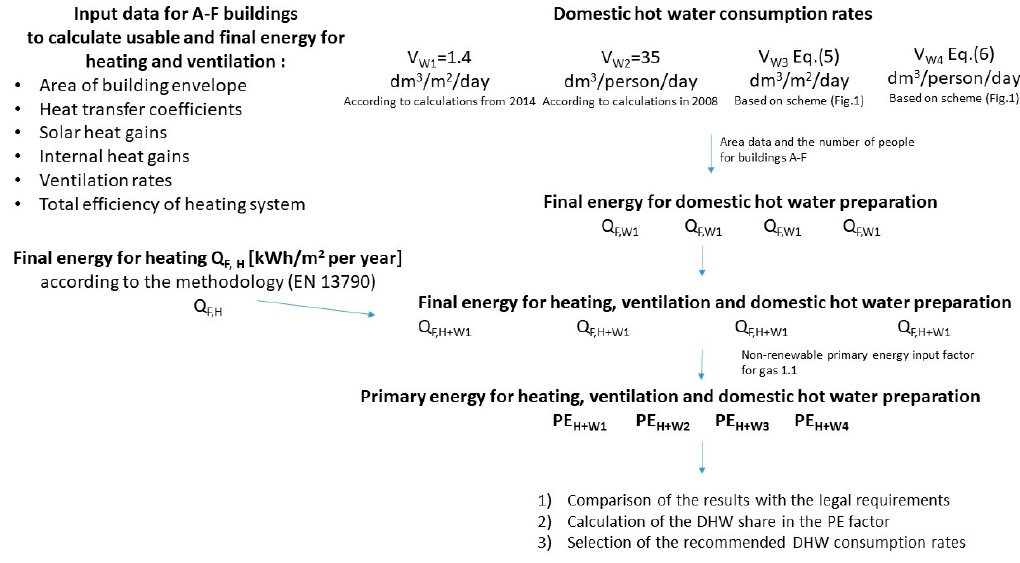
Figure 5. Diagram for calculating the energy rating and the impact of various water consumption indicators on the calculated PE indices.